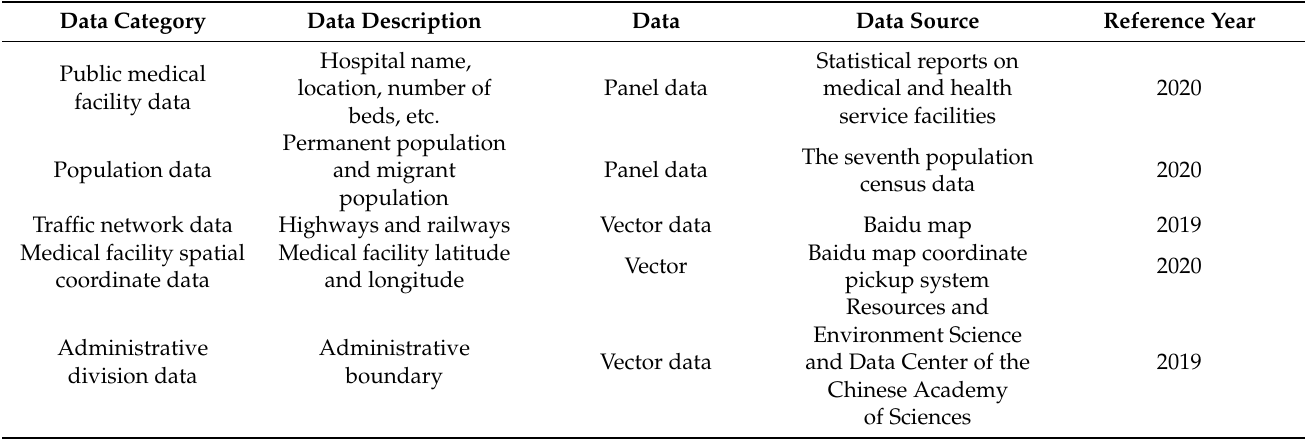
Table 1. Data sources and